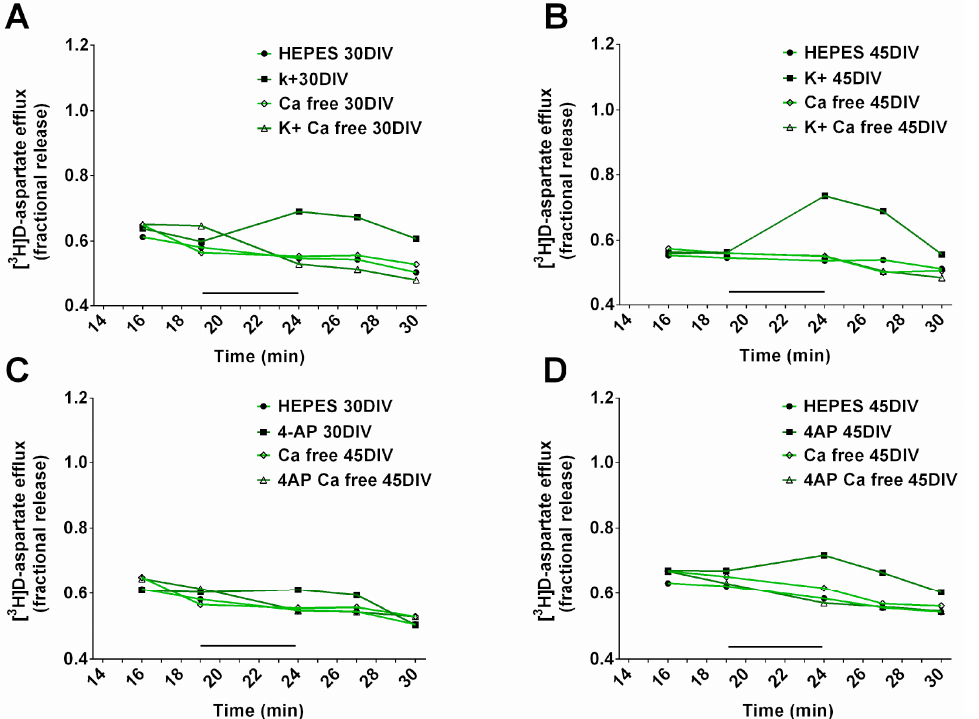
Figure 6. Exocytotic (Ca 2+ -dependent) release of glutamate from hiPSC-derived neurons at 30 and 45 DIV. ( A ) K + -evoked glutamate release from hiPSC-derived neurons in superfusion at 30 and 45 DIV. Data are expressed as mean ± SEM from three to seven different experiments. ( B ) 4AP-evoked glutamate release from hiPSC-derived neurons in superfusion at 30 and 45 DIV. Data are expressed as mean ± SEM from three to seven different experiments. ( A ) *** p < 0.001 vs. effect in NPCs, # p < 0.001 vs. K + in 1.2 mM Ca 2+ at the same day of differentiation and $ p < 0.05 vs. K + in 1.2 mM Ca 2+ at 30 DIV; ( B ) *** p < 0.001 vs. 4-AP in NPCs, # p < 0.001 vs. 4-AP in 1.2 mM Ca 2+ at the same day of differentiation (one way ANOVA followed by Bonferroni’s post hoc test). For other experimental details see Materials and Methods.